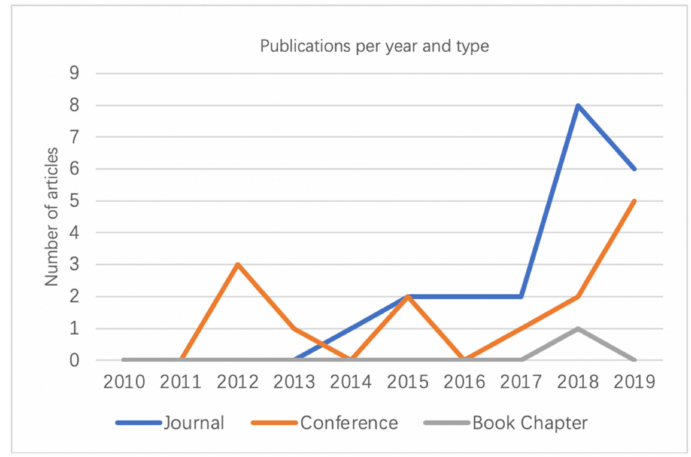
Figure 2. Publications per year and